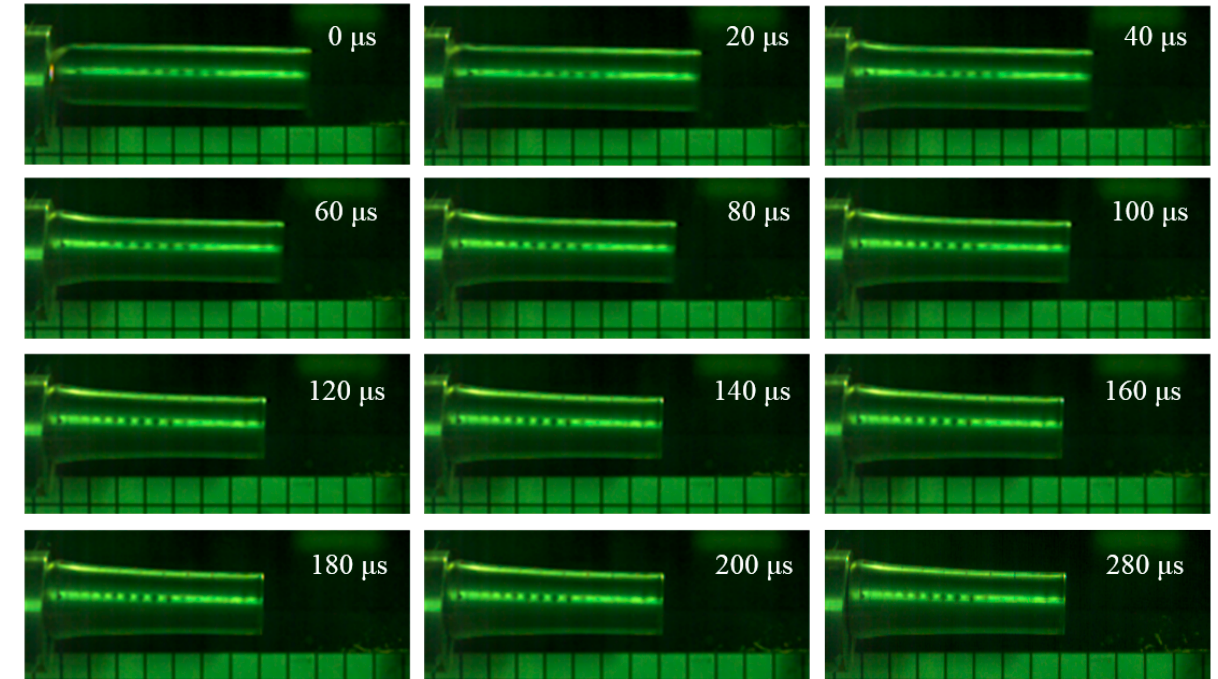
Metals 2021 , 11 , x FOR PEER REVIEW 8 of 21